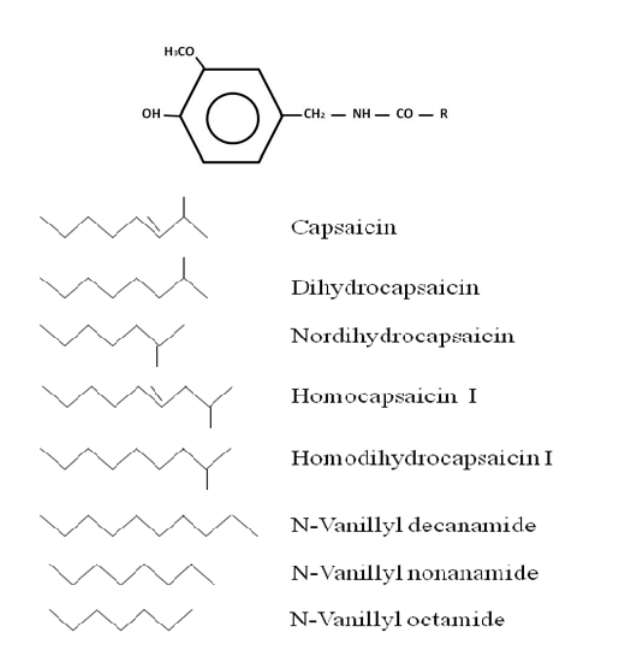
Figure 2. Chemical structure of different capsaicinoids and their analogues. R Capsaicinoids and